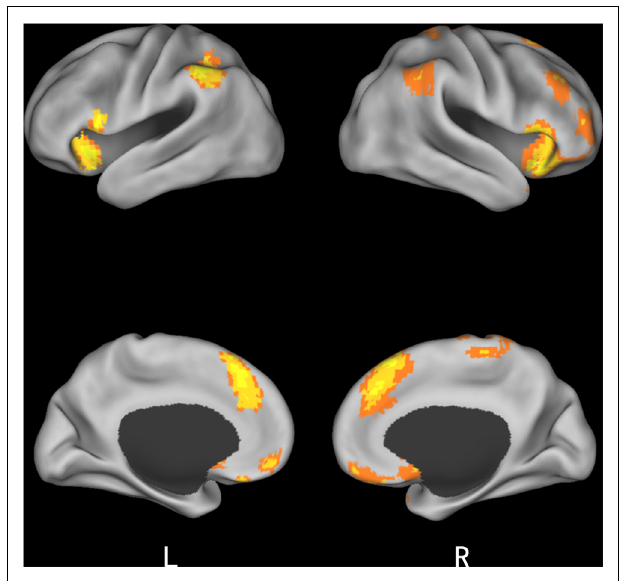
FIGURE 2 | Brain regions involved in the initial choice type and offer type interaction.